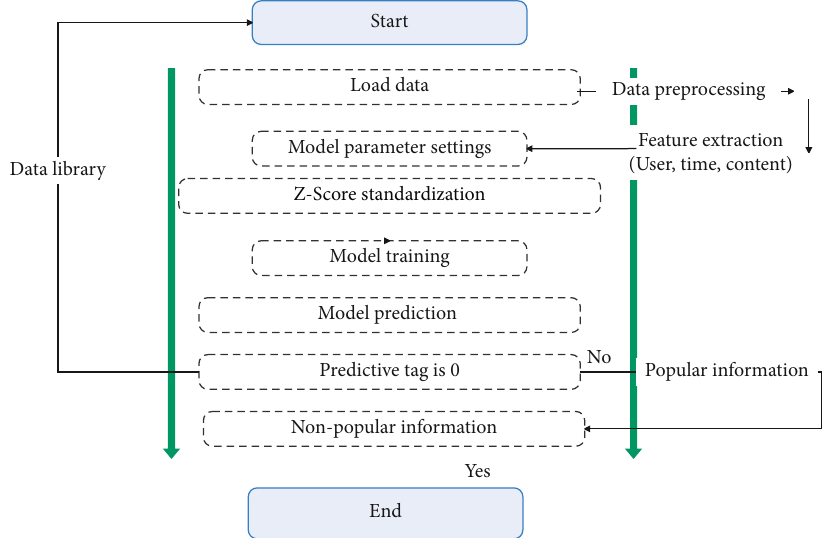
Figure 7: Popular information detection process.